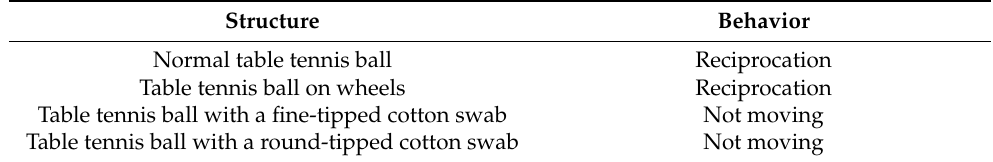
Table 1. Behavior of each